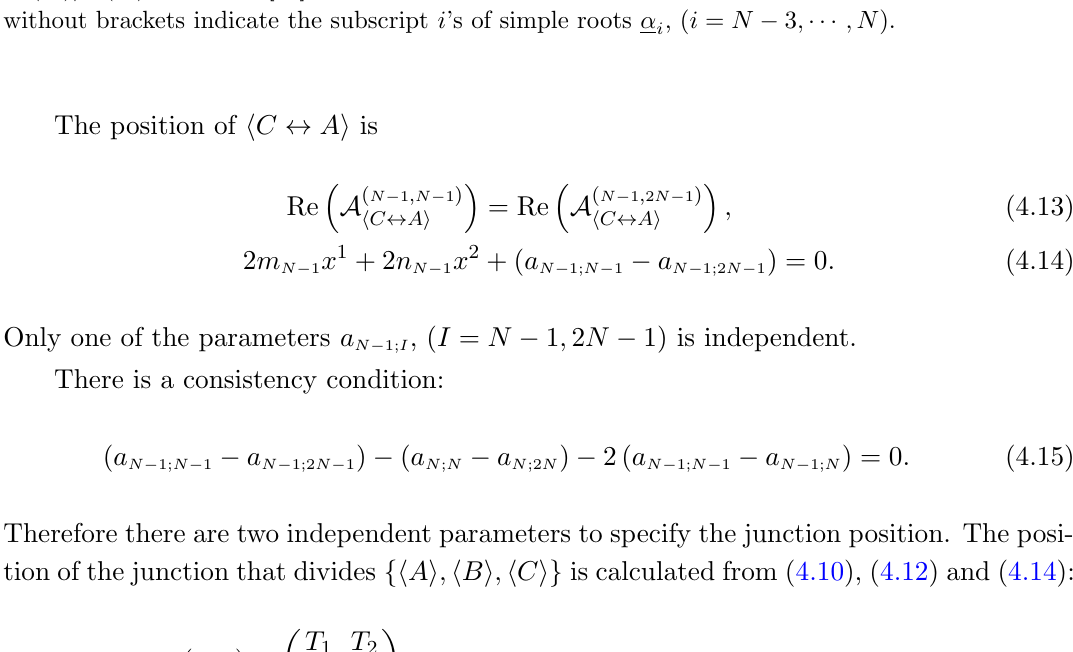
, ( i = N (cid:0) 3 ; (cid:1) (cid:1) (cid:1) ; N ). i